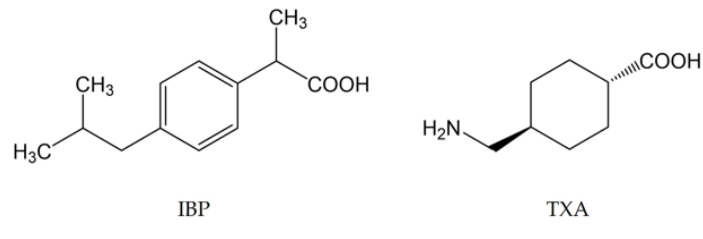
Figure 1. Chemical structures of IBP and TXA.